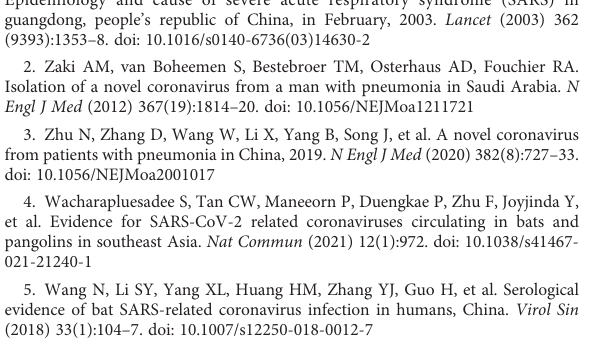
SUPPLEMENTARY FIGURE 1 Human ACE2-Fc proteins activate Fc g RIIIa and Complement. (A) Fc g RIIIa binding. The ACE2-Fc WT fusion proteins and their variants (5 µg/ml) were reacted with Ramos-S cells (Ramos cells expressing spike protein) and Fc receptor binding evaluated by fl ow cytometry using biotinylated dimeric rsFc g RIIIa, followed by streptavidin-APC. (mean of 3 replicates). (B, C) Activation of Fc g RIIIa. ACE2-Fc proteins are potent activators of Fc g RIIIa apart from the Fc H429Y mutants which fail to stimulate Fc g RIIIa in any ACE2 format. Ramos-S target cells were opsonized with (B) trACE2-Fc and (C) fl ACE2-Fc, WT and separately with Fc variants, including H429F, F; H429Y unfractionated, Y; H429Y oligomers, Y og ; H429Y monomer, Y mn ; E430G, G ortrACE2-Fc kif produced fromtrACE2-Fc WT in 293Expi cells in thepresenceofthemannosidaseinhibitorkifunensine.Ramos-Stargetcells were separately opsonized with Rituximab, RIT. These opsonized targets were incubated with Fc g RIIIa-NF- k B-RE nanoluciferase reporter cells and Fc g RIIIa activation measured by the induction of nanoluciferase (RLU). Representative activation data showing fi tting to agonist response curves to determine each EC 50 (nM) data point shown in Figure 5A . (D) ACE2-Fc fusion proteins comprising Fc regions with either of the H429F and E430G mutations, strongly fi x complement C5b-9. In ELISA analysis the indicated concentration series of trACE2-Fc or its Fc variants, was bound to SARS- CoV-2 spike RBD-biotin (2.5 m g/ml) captured by plate bound avidin (2 m